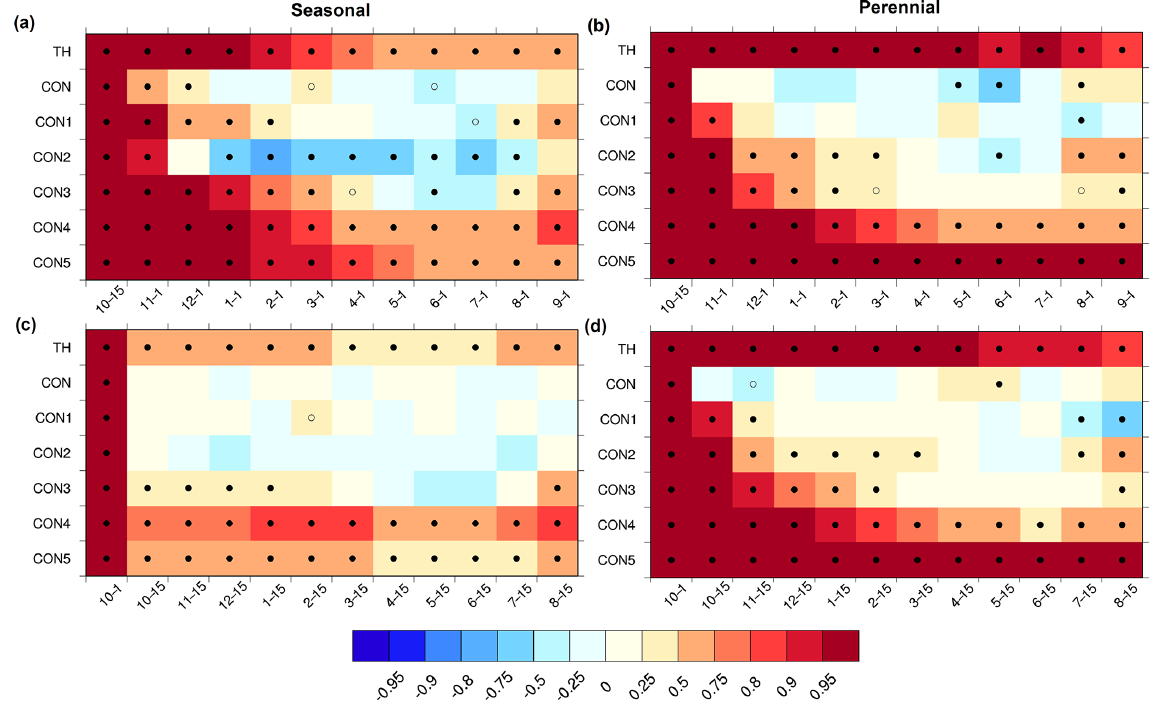
Figure 8. Correlation coefficients for sea ice variables between the initial condition and conditions throughout the year for seasonal (a, c) and perennial (b, d) tracks initialized on 15 October ( a, b ; top row) and 1 October ( c, d ; bottom row). Solid (open) black dots indicate statistical significance at the 95% (90%) confidence level. From top to bottom, the variables shown are grid cell along-track mean ice thickness (TH), grid cell mean ice concentration (CON), and ice concentration for categories 1–5